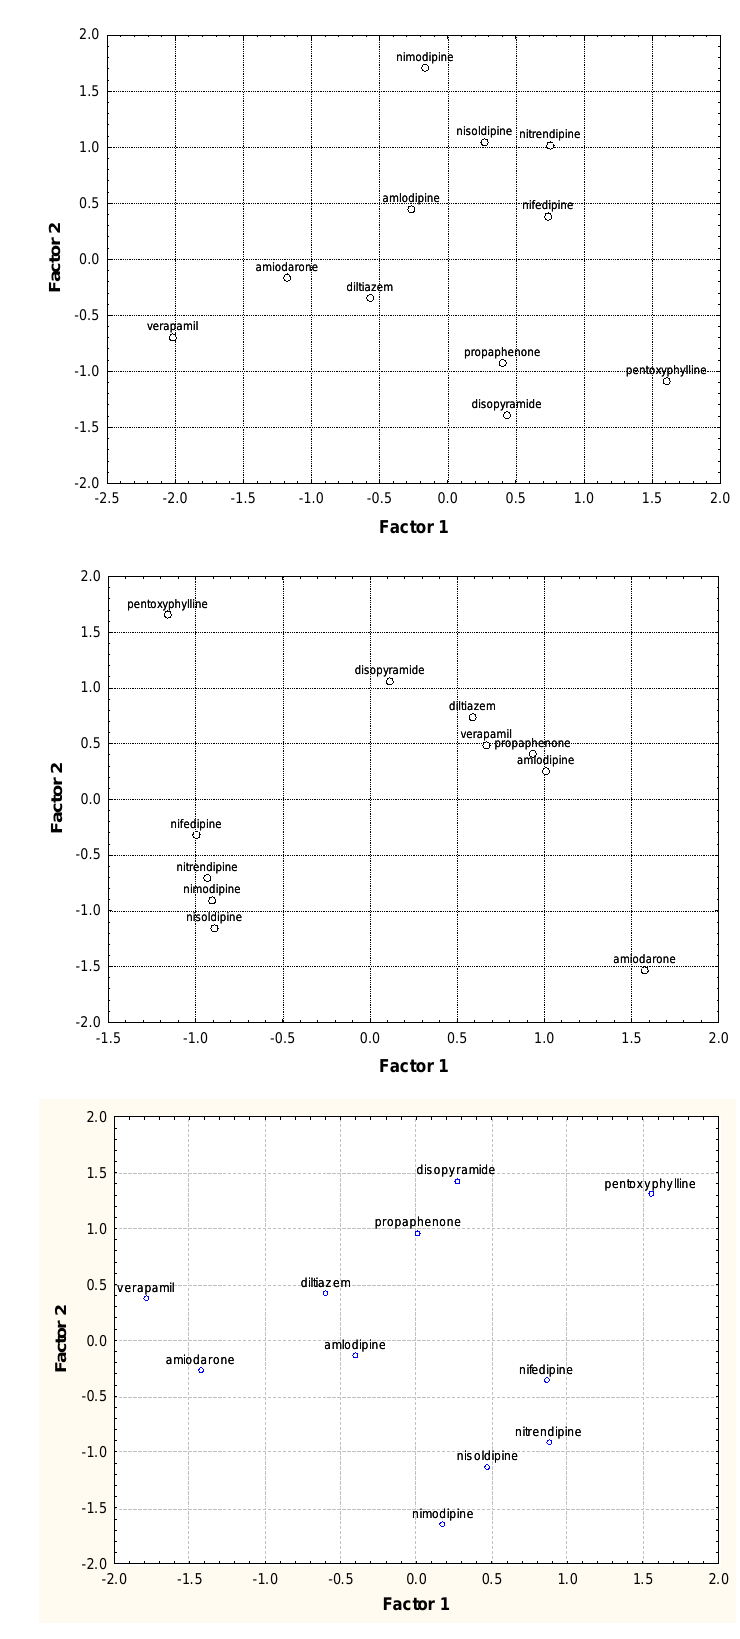
Figure 3. Two-dimensional scatter plots of the scores of individual drugs in the first two factors extracted: a) from structural parameters, b) from HPLC retention data, c) from structural parameters and HPLC retention